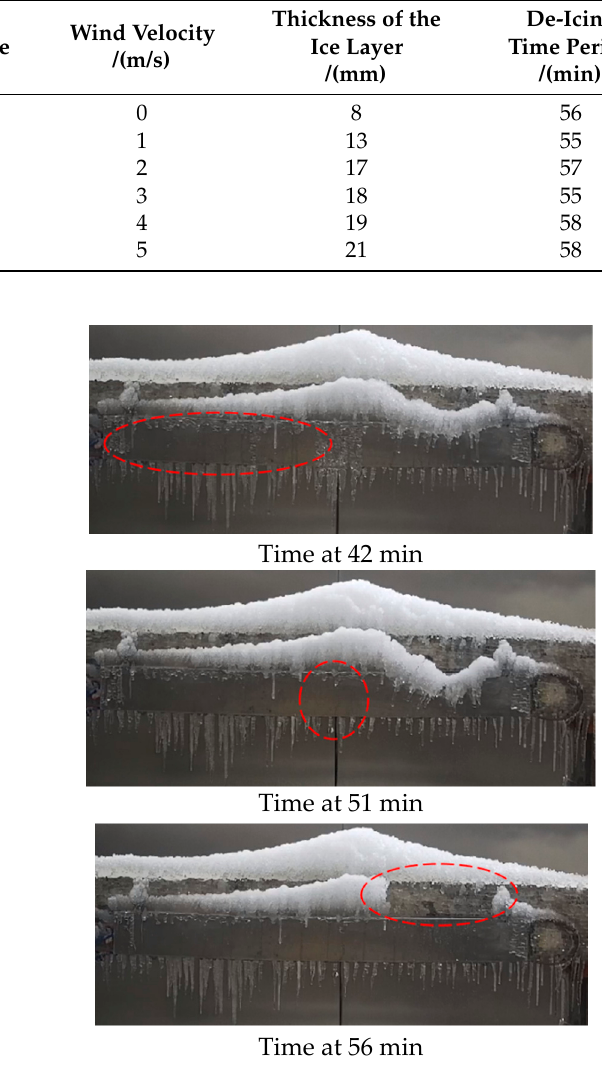
Figure 16. Passive de-icing process without wind. The initial time of heating was recorded as time 0. At the time of 39 min, due to the increase in internal temperature, the ice layer in the left part of the heating system surface began to fall off. In the following three minutes, a large area of ice fell off. By the time of 51 min, the ice layer on the wall surface of the heating system was almost completely removed. At the time of 56 min, the extended ice on the top surface of the heating system fell off, and the ice melting process